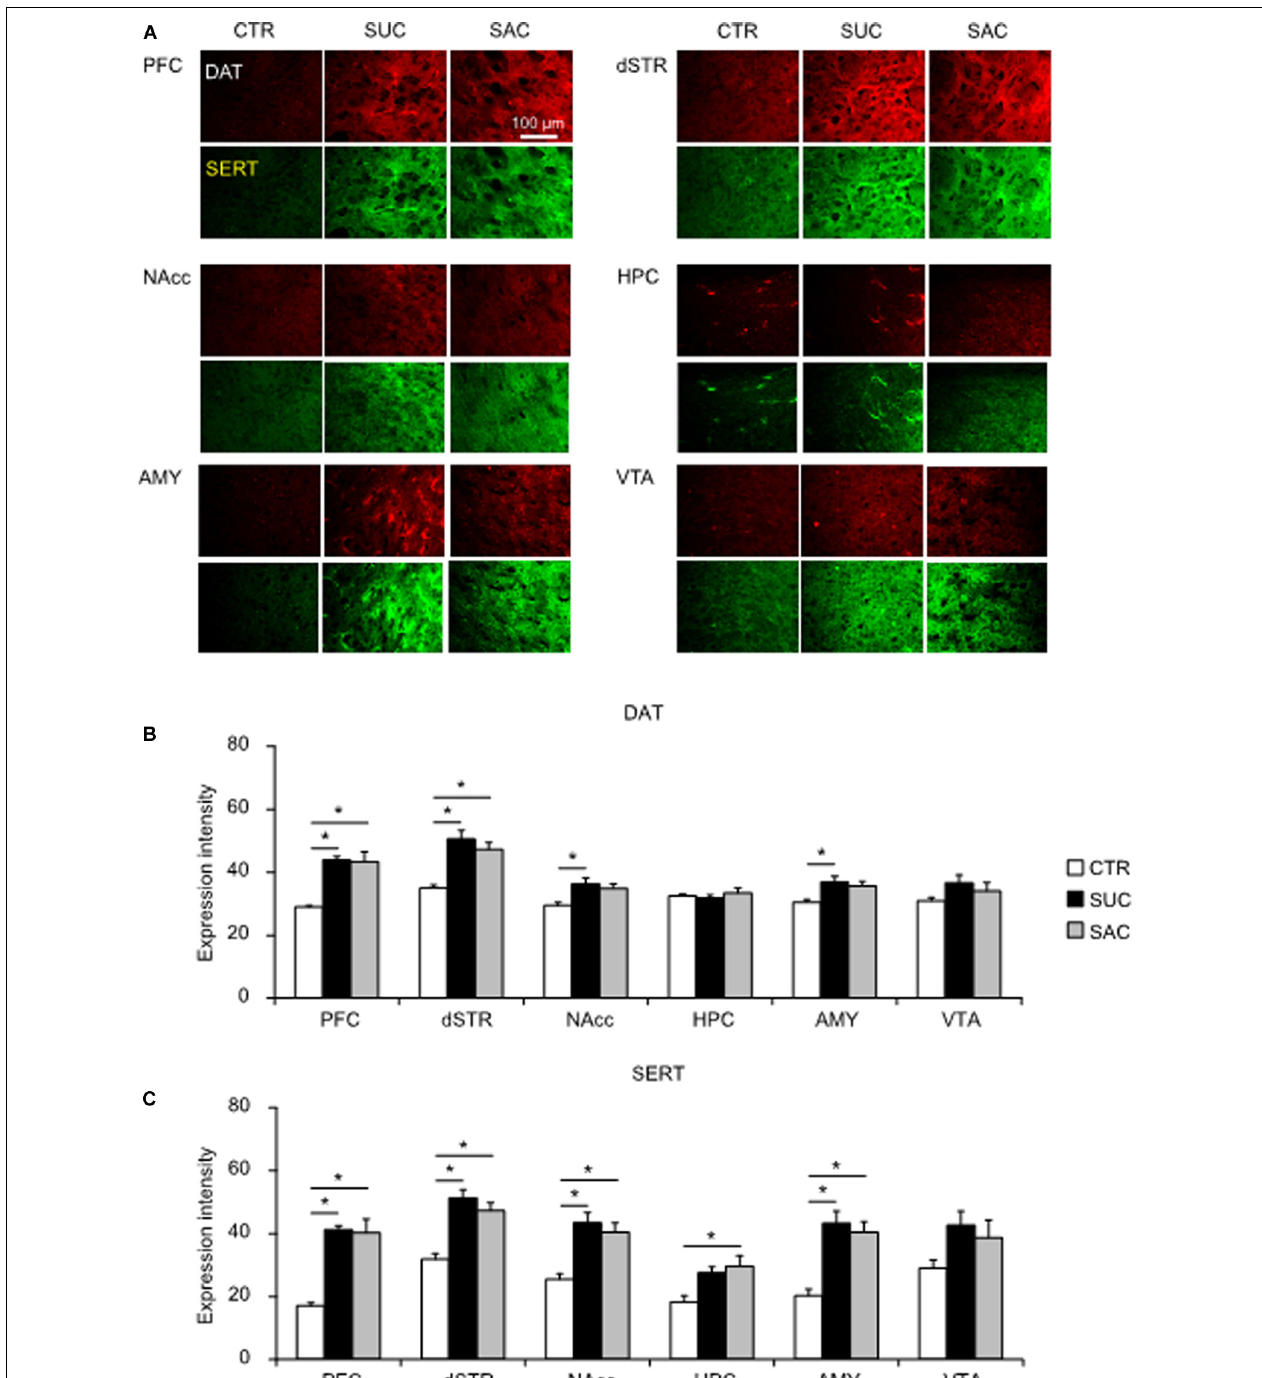
FIGURE 6 | Alterations of dopamine and serotonin transporter expression levels in mesocorticolimbic regions of adult animals subjected to sucrose and saccharine treatments. (A) Representative images of DAT (red) and SERT (green) expression in mesocorticolimbic regions of adult animals. Graph showing fluorescence intensities of DAT (B) and SERT (C) expression in adult animals. * p < 0.05.